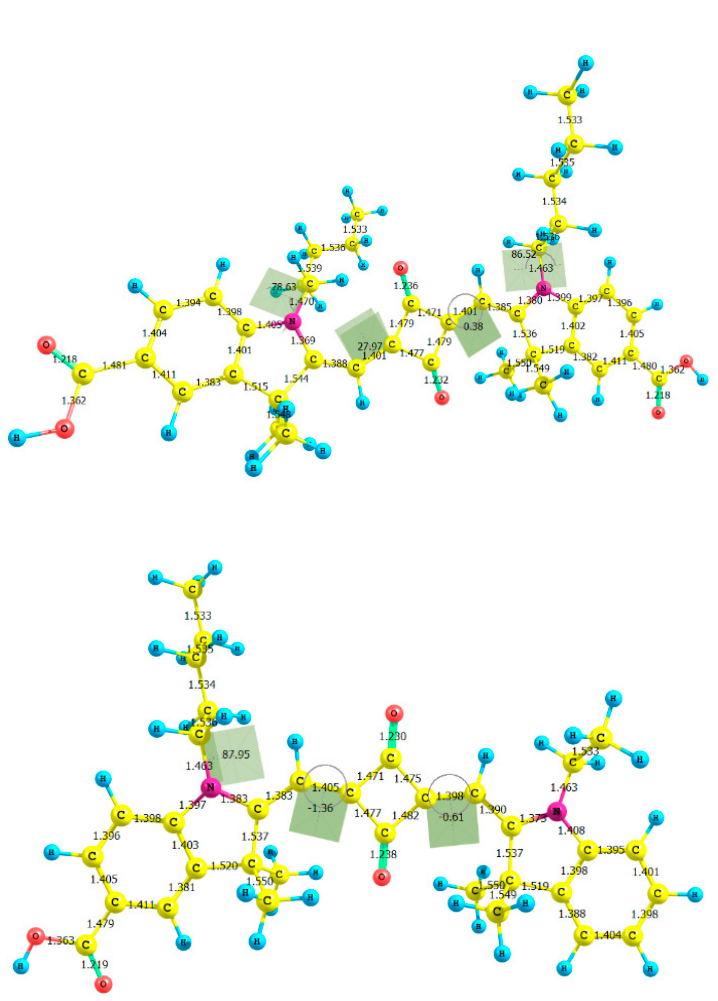
Figure 1. Figure 1. Cont.